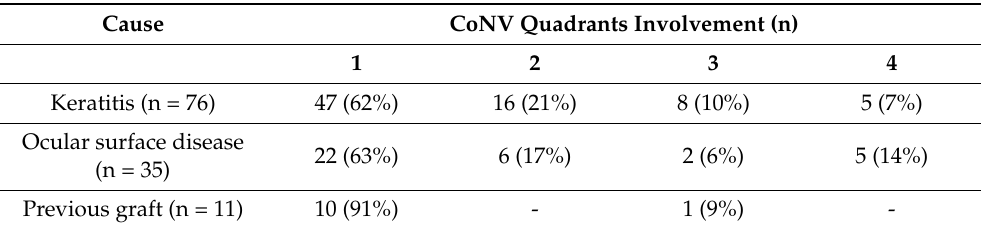
Table 1. Disease and number of quadrants of corneal neovascularization (CoNV). Cause